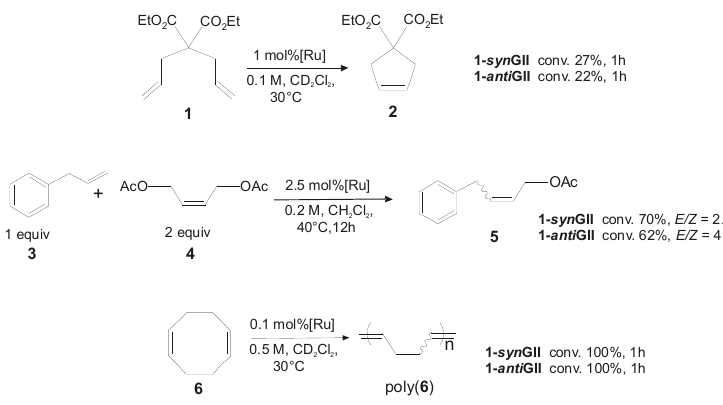
Scheme 1. Representative RCM, CM and ROMP metathesis reactions.